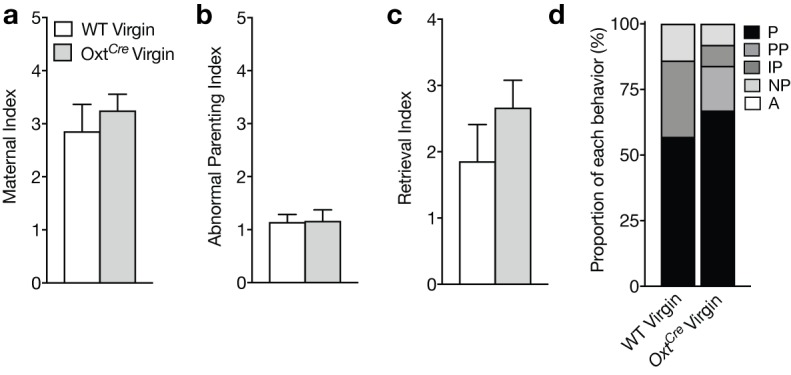
OxtCre mice show normal maternal behavior.(a-c) Maternal (a), abnormal parenting (b), and retrieval (c) indices for WT and OxtCre virgins during foreign pup retrieval test. OxtCre virgin females show no differences on these indices compared to WT virgins (Mann-Whitney tests, p>0.05). (d) Proportion of WT and Bdnf-e1 -/- virgin females with different maternal types including parenting (P), partial parenting (PP), irregular parenting (IP), non-parenting (NP), and attack (A). OxtCre virgins show normal parenting behavior (Wilcoxon rank sum test, p>0.05). Data are means ±SEM. (n = 7 WT adult virgin females; n = 12 OxtCre adult virgin females).